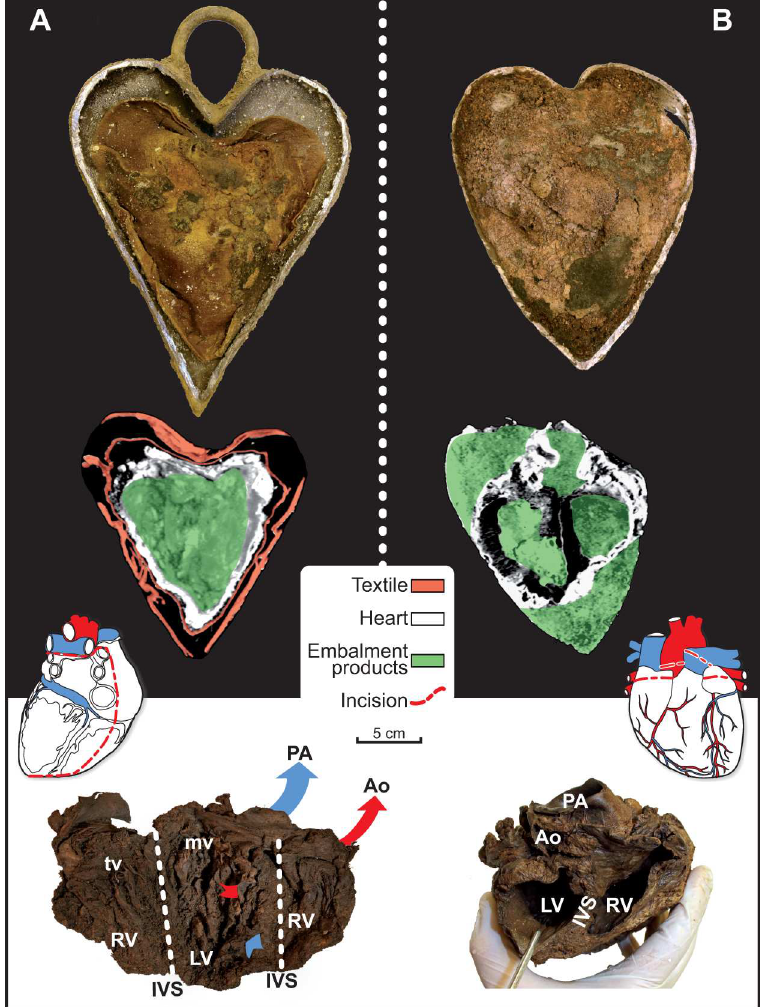
Fig 6. Protocol for Embalming Hearts. The major blood vessels were severedat the point where they exited the heart. The heart was coveredwith either grain or vegetablefiber that was also inserted into the ventricles. Two of the four well-preservedhearts had been embalmed,with incisionsmade in each of the atria to allowthe ventriclesto be paddedindividually,thereby maintainingas much as possibletheir originalshape (A). The right ventriclesof the other two hearts had been slit open from the apex to the top of the atrium, after which the interventricular septum was cut, thus mergingthe two ventricular cavities, which were then filled with either fiber or grain or both (B). PA: pulmonary artery; Ao: aorta; LV: left ventricle; RV: right ventricle; IVS: interventricular septum; tv: tricuspid valve; mv: mitral